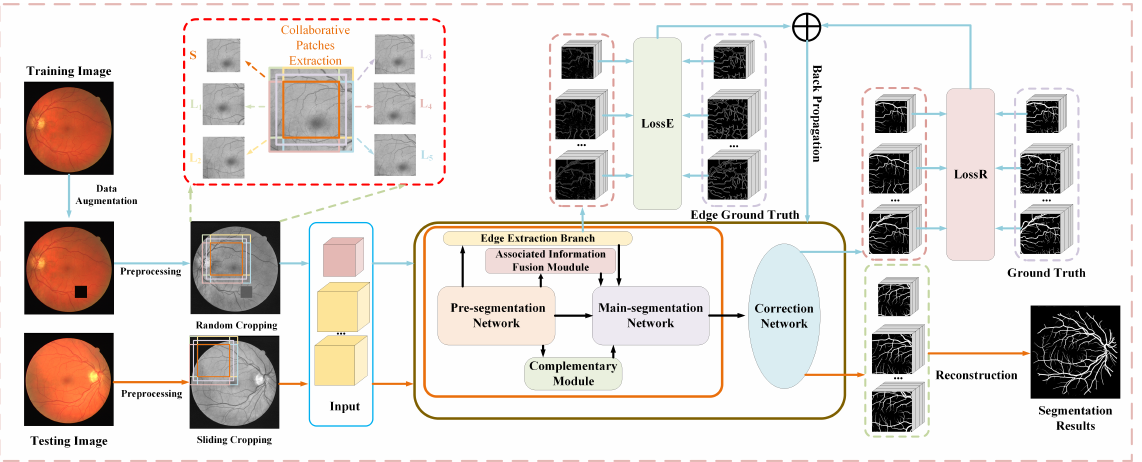
Figure 1. Flow chart of the proposed method. The gray dotted box shows the patch extraction process. The extracted small patch corresponds to the target area, and each of the large patches corresponds to the combination of the target area and some global information.